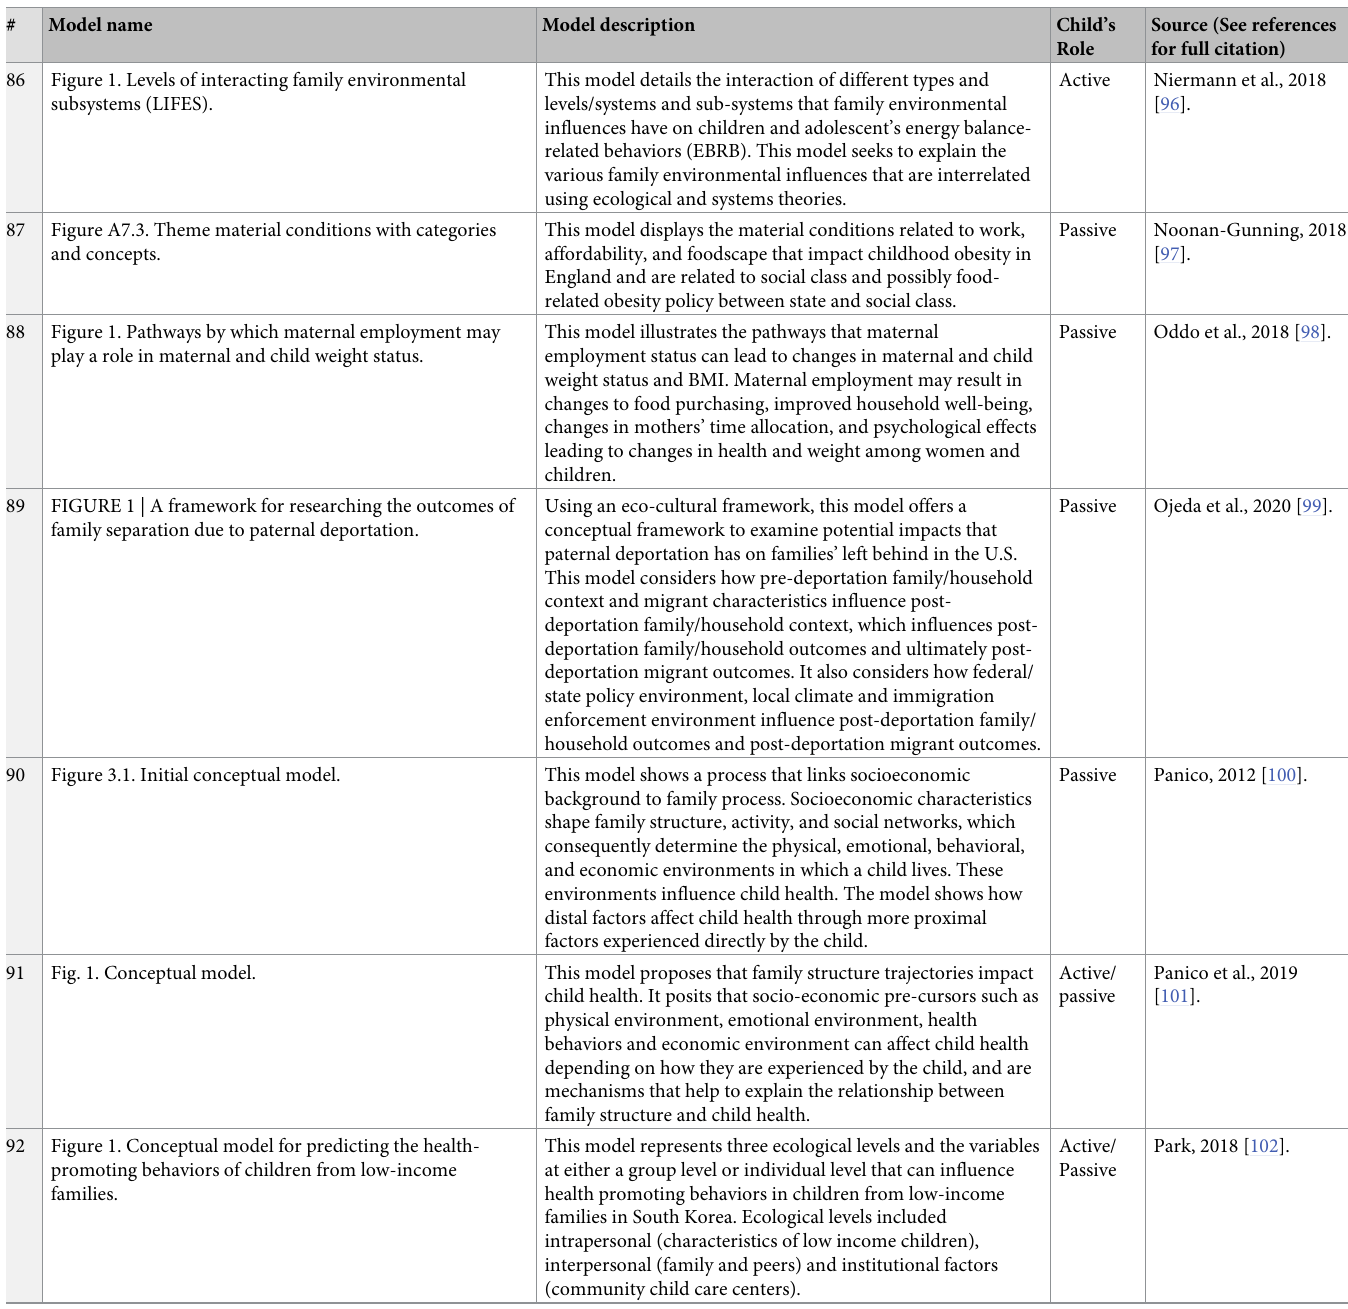
Figure 1. Levels of interacting family environmental subsystems (LIFES).